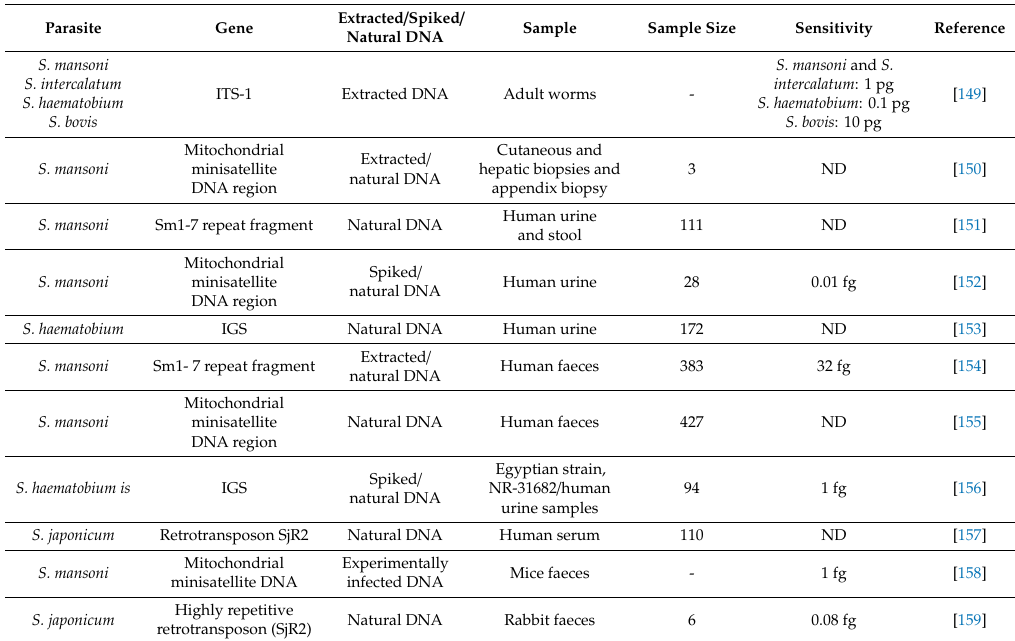
Table 15. Publications found in the US National Library of Medicine National Institutes of Health (NCBI-PubMed) reporting the standardisation of the LAMP technique as a useful tool for diagnosing schistosomiasis in the definitive host.